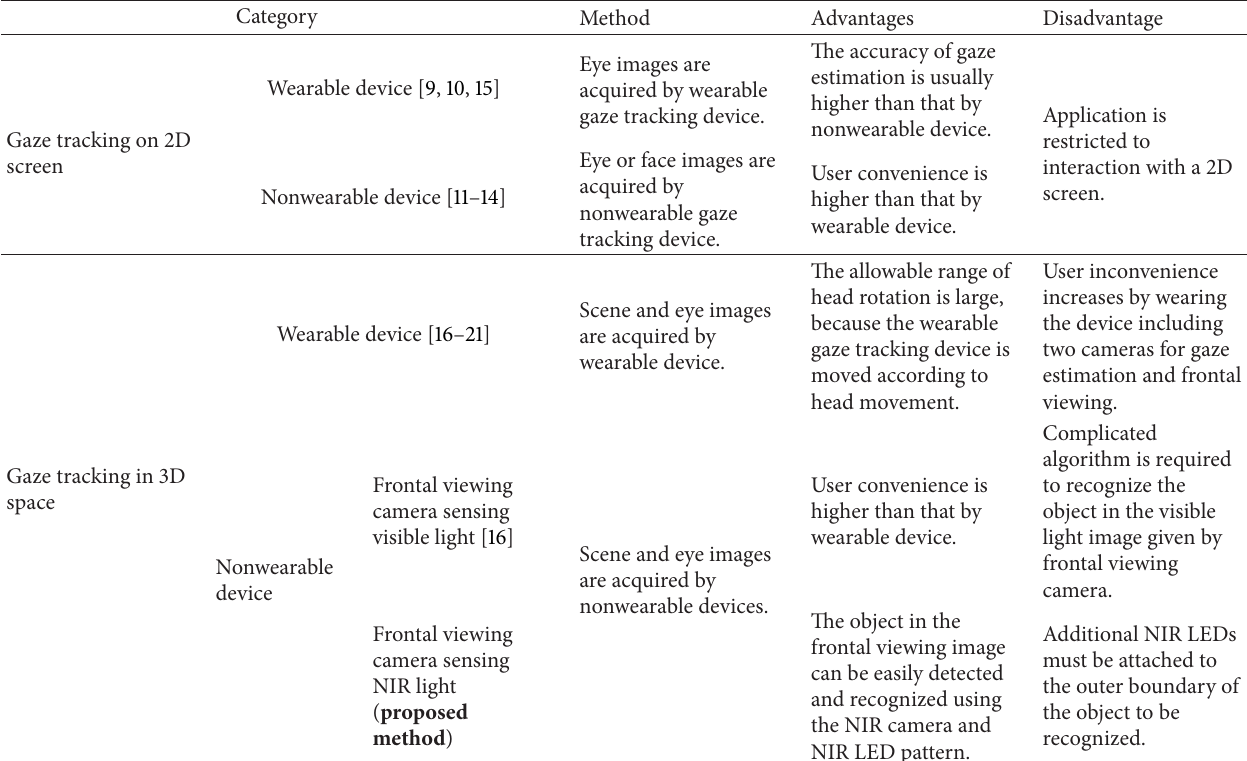
Table 1: Summaries of proposed and previous approaches.